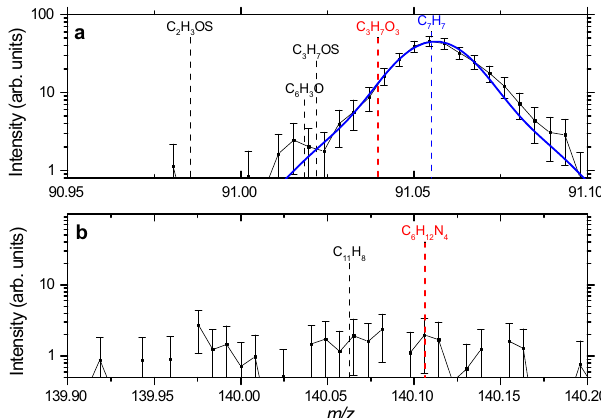
Fig. 2 Mass spectra from 3 August 2015 at the exact masses of two typical multimers. Intensities measured by the Double Focusing Mass Spectrometer (DFMS) are given in arbitrary units (arb. units) with error bars representing 1 σ statistical errors. a Fitting a double Gaussian peak function (blue line) as detailed in the Methods section shows that the H-terminated linear trimer fragment of polyoxymethylene (C 3 H 7 O 3 ) is absent or within error margin on m/z = 91. The prominent signal corresponds to the tropylium ion (C 7 H 7 ), mostly originating from the fragmentation of toluene (C 7 H 8 ). b On m/z = 140, the pure hydrocarbon position is separable from the molecular ion signal